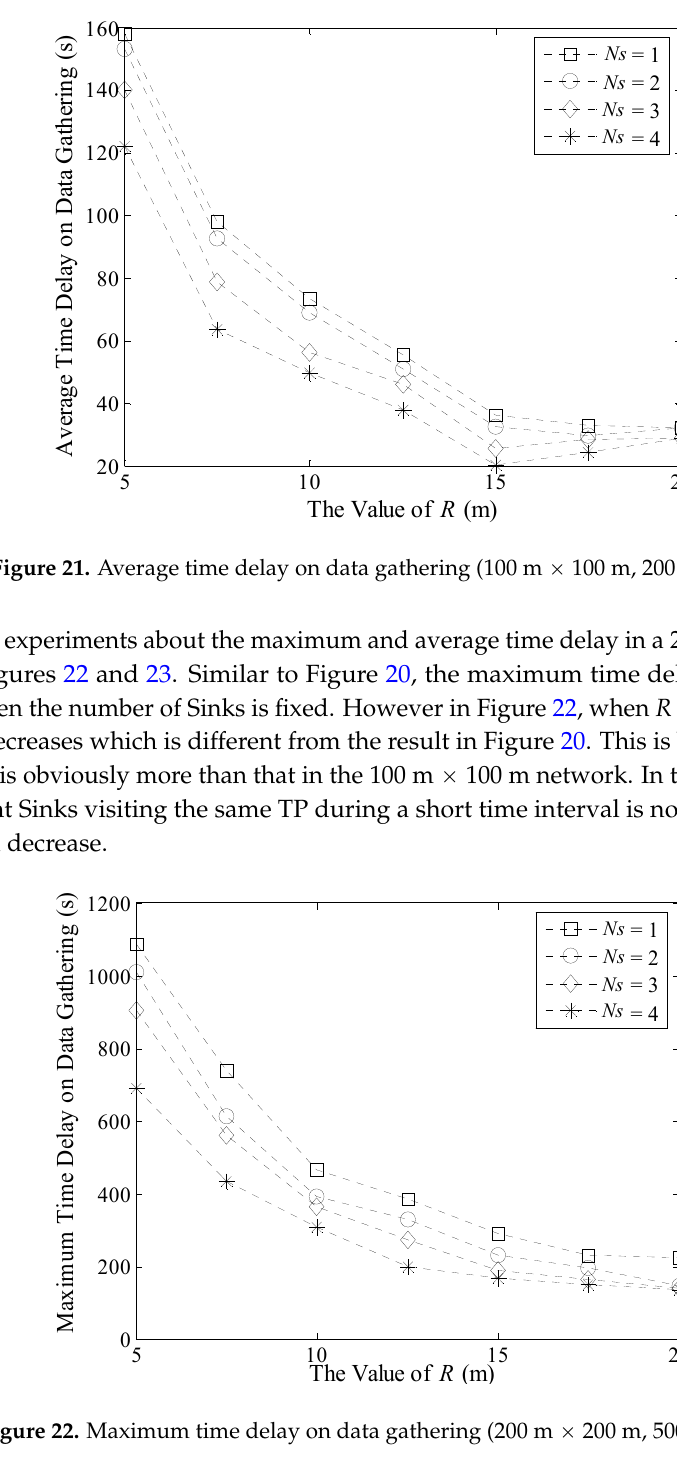
Figure 20. Maximum time delay on data gathering (100 m × 100 m, 200 nodes).